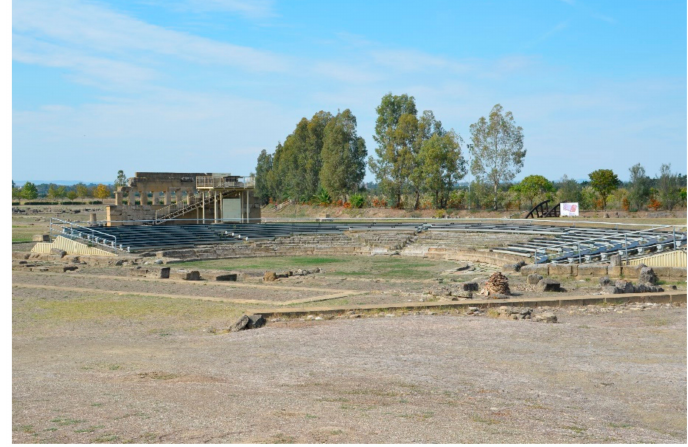
Figure 2. The Theater of Metaponto (Author: AlexanderVanLonn, source: https://commons. wikimedia.org/wiki/File:Metapontum_theater_AvL.JPG (accessed on 4 March 2021), license: CC-BY- SA-3.0).